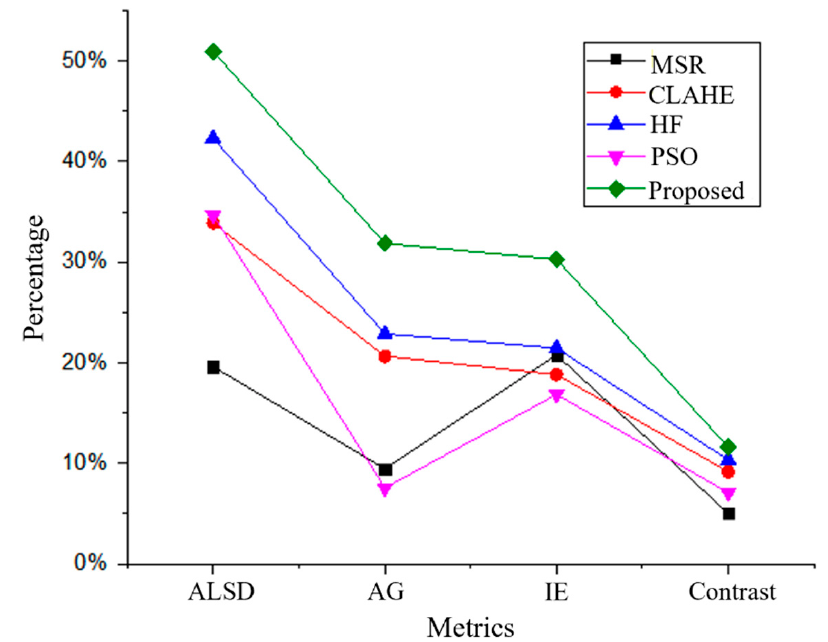
Figure 13. Percentage enhancement of mine image.